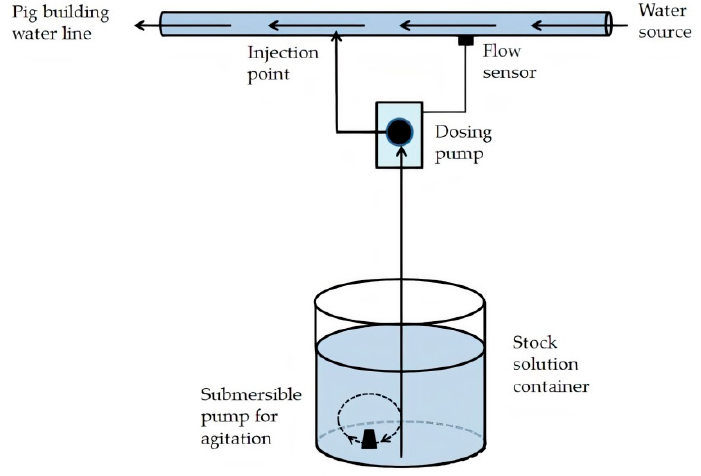
Figure 3. Dosing equipment used in Studies 1a, 1b, 2a and 2b.